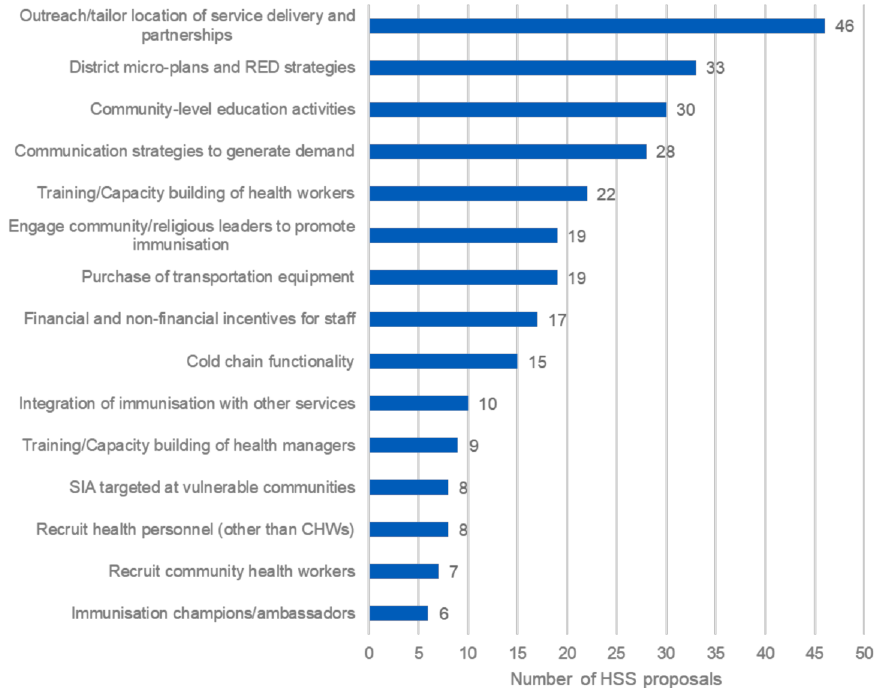
Figure 1. The 15 most common pro-equity intervention categories listed in the HSS proposals.